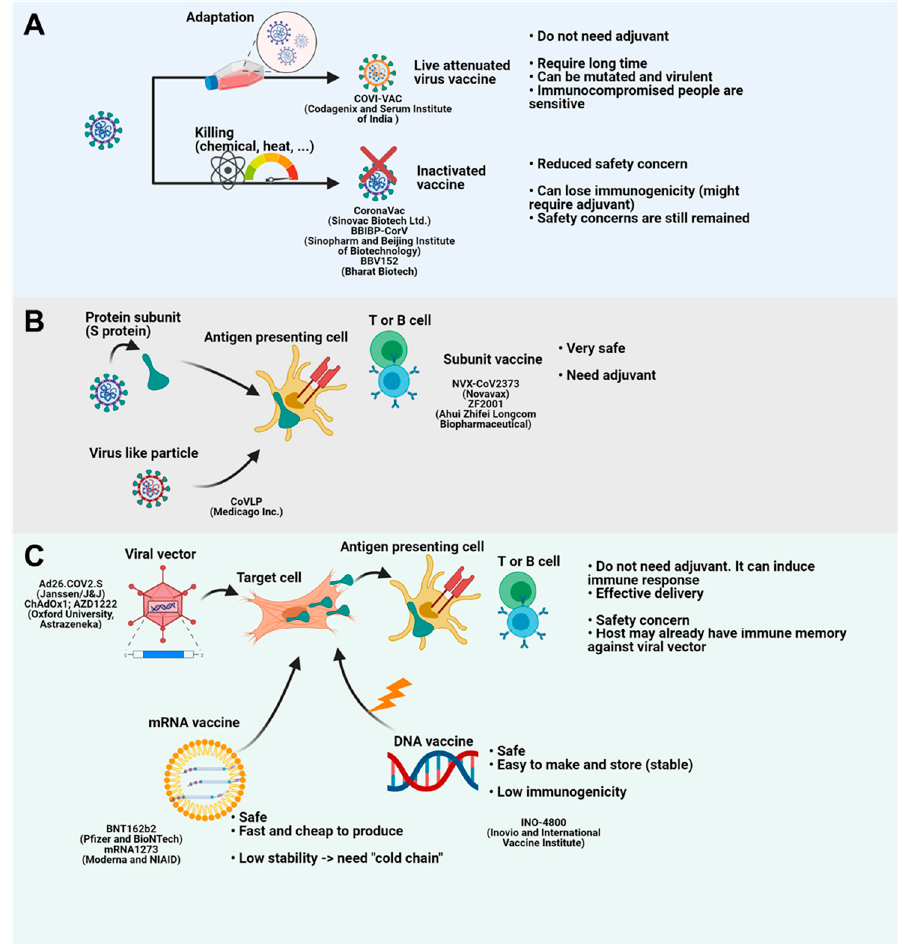
Figure 2. Vaccine platforms for COVID-19. ( A ) Live attenuated vaccines are developed through repeated attenuation. Inactivated vaccines are generated by chemical or heat stress. Live attenuated vaccines do not require adjuvant. However, this technology takes a long time and has safety concerns. Inactivated vaccines have reduced danger compared to attenuated vaccines. However, they need adjuvant because they lose their immunogenicity. ( B ) Protein subunit vaccine or subunit-containing virus like particle (VLP) provides antigen to antigen presenting cells (APCs). APCs present antigen to immune cells and generate immune memory. Although these platforms are safe, they need adjuvant. ( C ) Viral vector vaccines deliver antigen-coding genes to target cells. Infected cells make and give antigen to APCs. Viral vectors do not need adjuvant because the vector itself is danger-associated molecular pattern (DAMP). Delivery is also easy. However, they have safety concerns and vectors can be eradicated by host immune memory if the host has experience of the viral vector. mRNA vaccine and DNA vaccine deliver mRNA and DNA to the target cells. mRNA and DNA generate antigens. While mRNA vaccines are safe, fast and cheap, they need “cold chain” because RNA is unstable. DNA vaccines are stable and safe. However, they are weak to induce proper immunity. Figure was created by biorender.com (BioRender, Toronto, ON, Canada). Viral vectors including adenoviruses, modified vaccinia Ankara (MVA), and vesicu- lar stomatitis virus (VSV) have been used successfully to produce vaccines against patho- gens such as the Ebola virus [1]. However, the host may already have immunity against some viral vectors, which must be considered in determining the prime and boost doses.